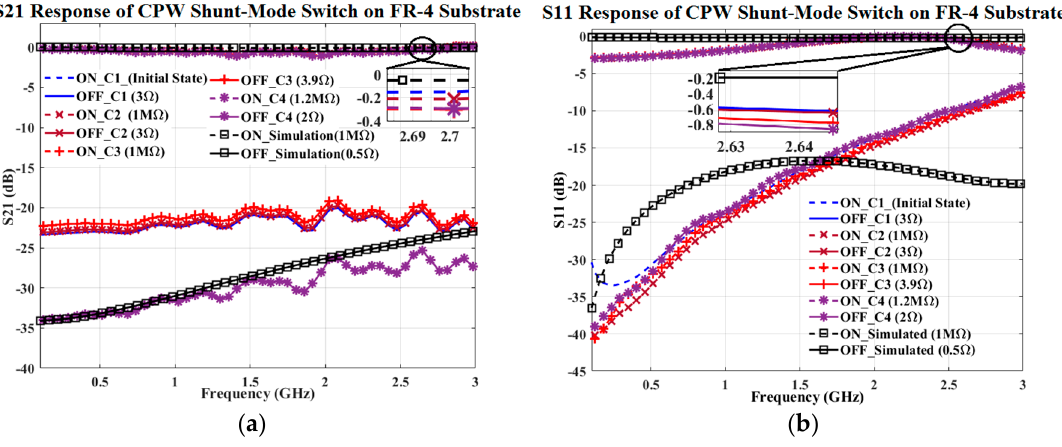
Figure 7. RF-response of the Co-Planar Waveguide (CPW) shunt mode switch on FR-4 substrate. ( a ) S21; ( b ) S11.